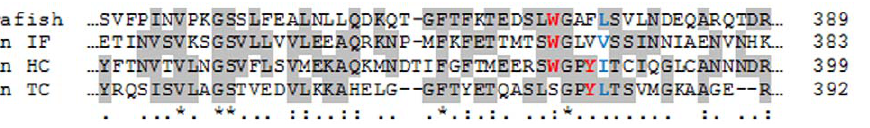
Figure 6. Partial Protein Sequence Alignment of the Primary Cobalamin Binding Site in the C-terminus. The sequence alignment of C- terminal domains of the zebrafish cobalamin binder and the human cobalamin binders was done in ClustalW2 using default settings. The residues highlighted in red residues are the ones that form hydrophobic interactions with the ligand and that are characteristic for the specificity for cobalamin (TC, HC, IF) and other corrinoids (only HC) [26]. The residues highlighted in blue form hydrogen bonds to the ligand [26]. Residue identities are on a gray background. The numbers in the right margin refers to the specific amino acids in the full-length protein including signal peptides.